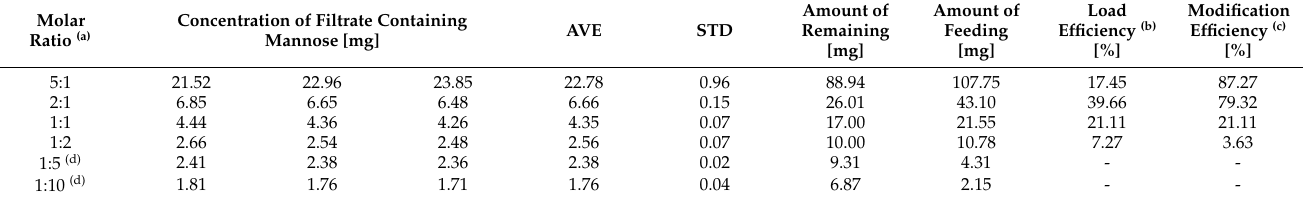
Table 1. The effect of different feeding ratios on the modified mannose amount of HA-man@Fe 3 O 4 . Molar Concentration of Filtrate Containing Ratio (a) Mannose [mg]